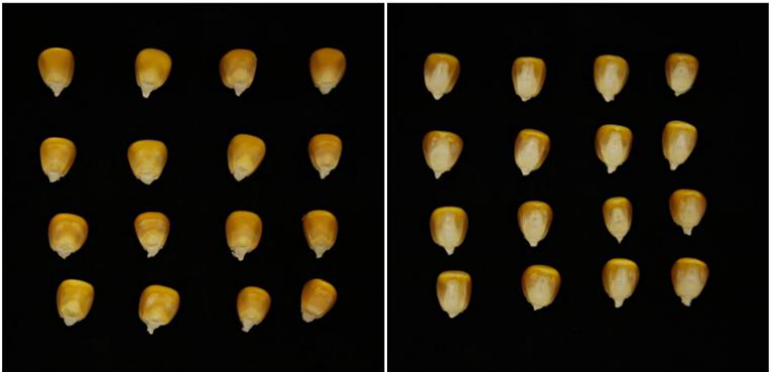
Figure 1. Multi-grain maize seed images.